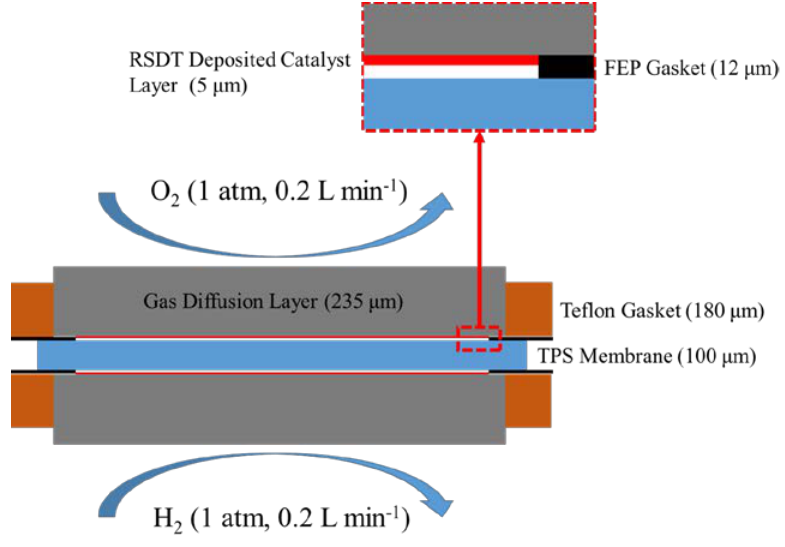
Figure 6. Schematic of the single cell cross section. Measurements in parenthesis indicate thicknesses on the specified